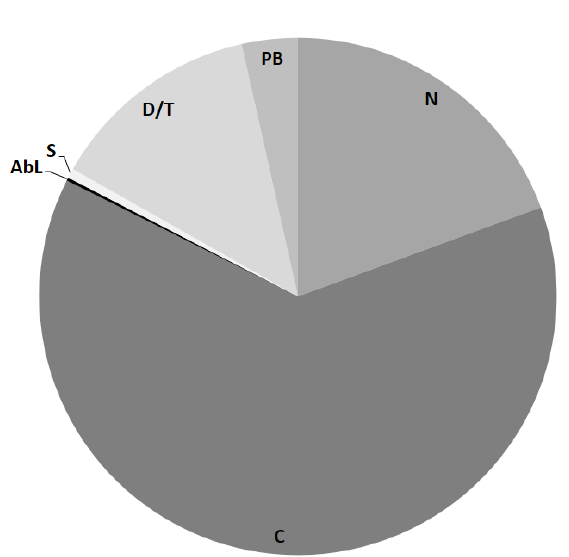
Figure 1. Variability of Hypolepis x paulistana spores. AbL= laesurae with abnormalities (0.2%), C = Collapsed spores (63%), D/T = Dyads or Tetrads (13.3%), N = Normal spores (19.4%), PB = Bodies of perisporic material (3.5%), S = Spheroidal spores